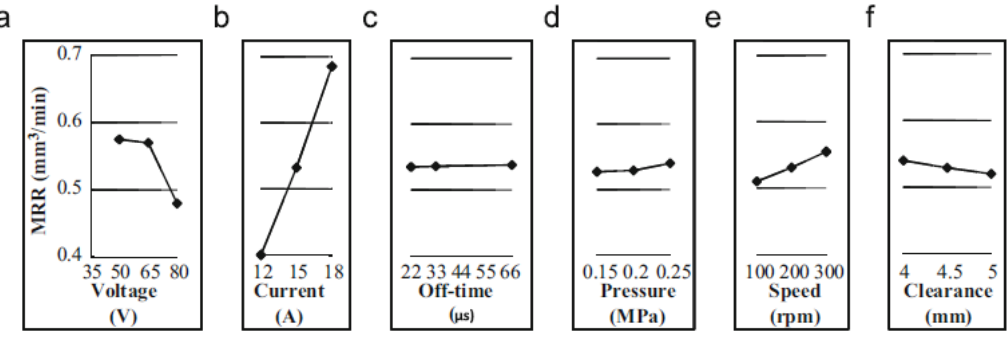
Figure 11. ( a – f ) Main effects of the input parameters associated with the MRR [174].